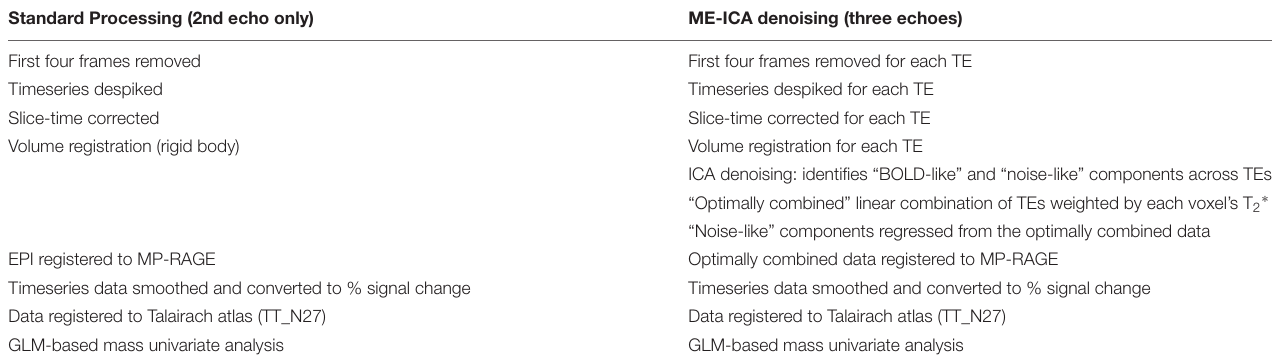
TABLE 1 | Summary of analysis pipelines compared in this